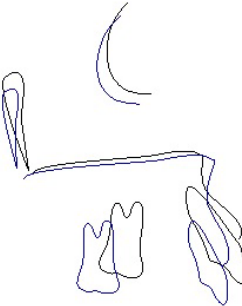
Figure 7. Superimposed tracings of the initial (blue line) and final (black line) cephalometrics. After two years of retention the results were steady (Figures 8 and 9), despite the fact that some authors claim that the more the body changes, the more likely it is for treatment to relapse [30].